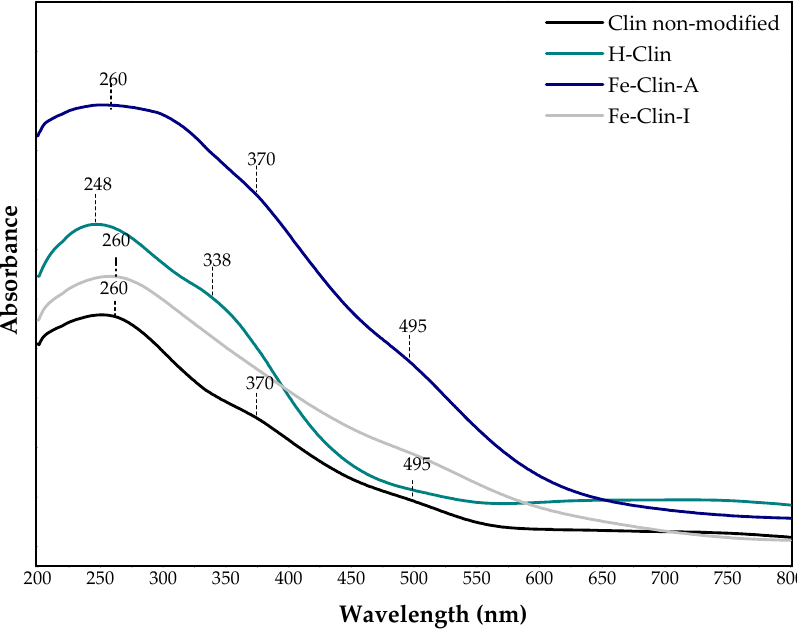
Figure 4. UV-vis spectra of non-modified clinoptilolite, H-Clin, Fe-Clin-A, and Fe-Clin-I.